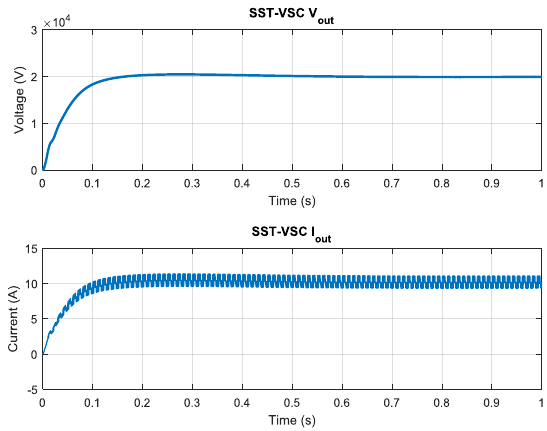
V with unbalanced loading is , DC mes